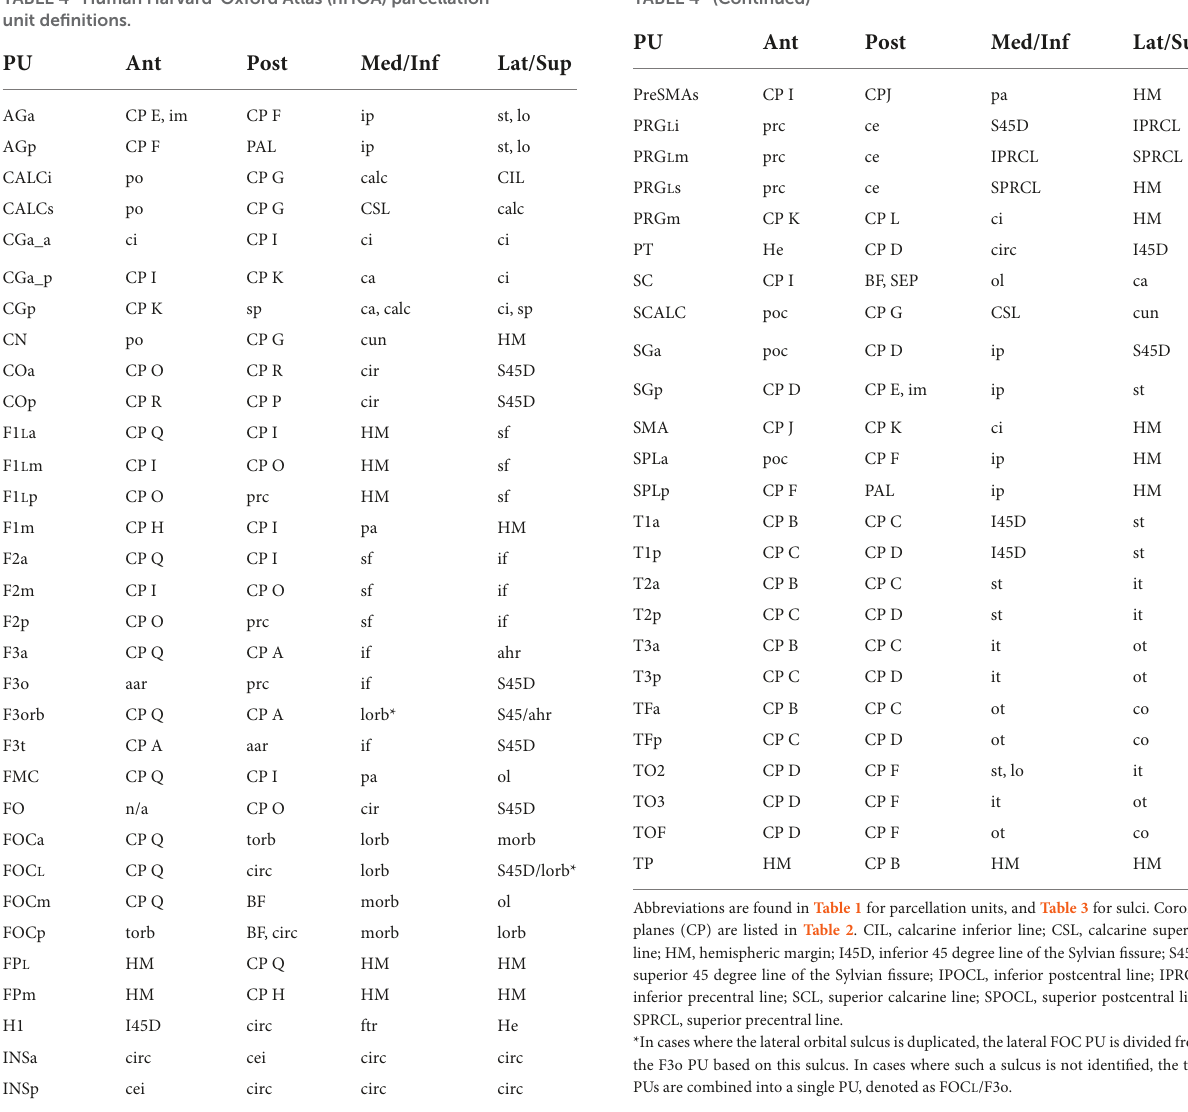
TABLE 4 Human Harvard-Oxford Atlas (hHOA) parcellation unit definitions.